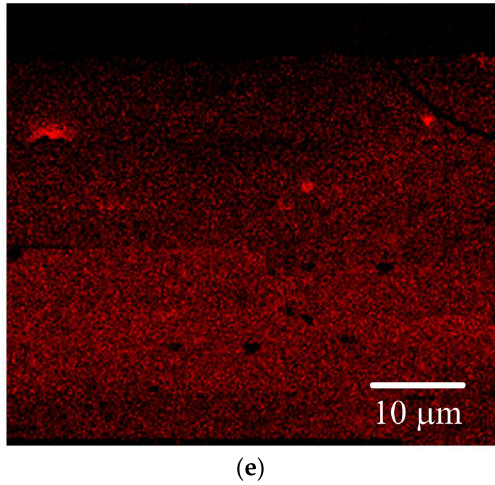
Figure 6. CLSM images of ( a ) PQ1, ( b ) PQ1.5, ( c ) PQ2, ( d ) PQ3, and ( e ) planer sample.